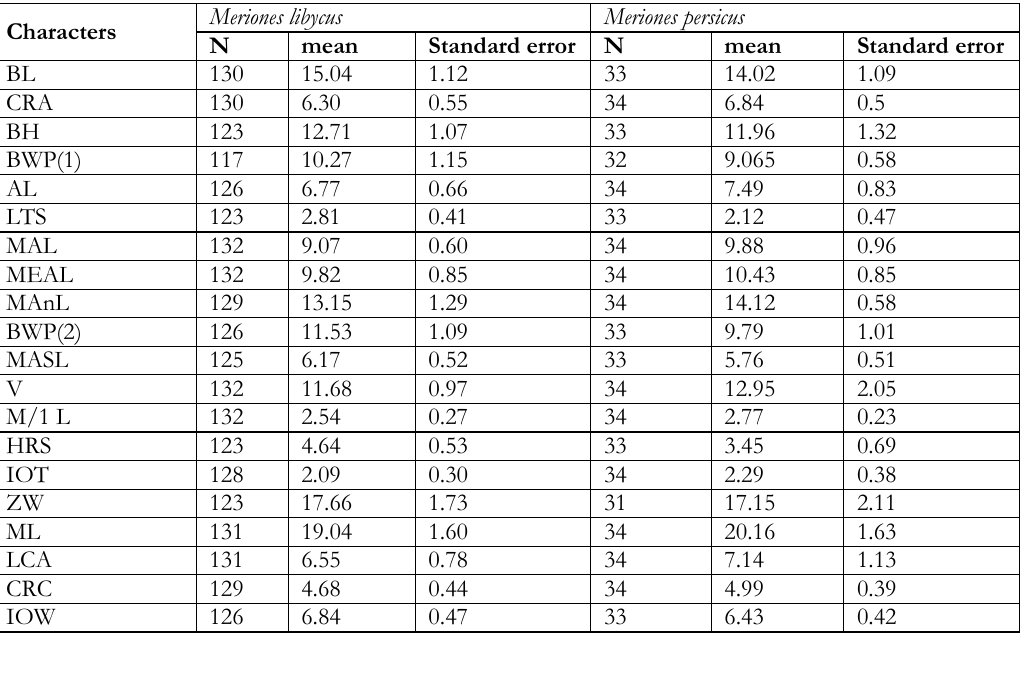
T ABLE 2 .- means and standard errors of 20 measured cranial characters in M. libycus and M. persicus